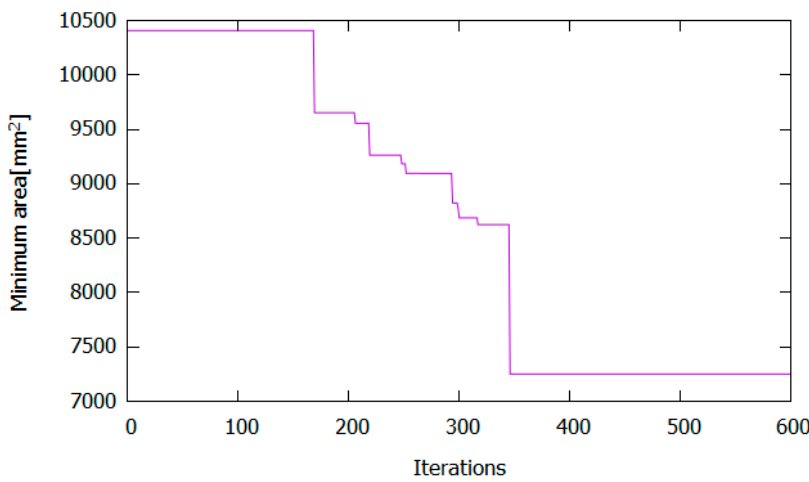
Figure 10. Variation in the minimum cross-sectional area with slender web under distributed loading in the first 600 harmony search iterations. Table 5. Geometric properties of the optimised cross-section with slender web under distributed loading.